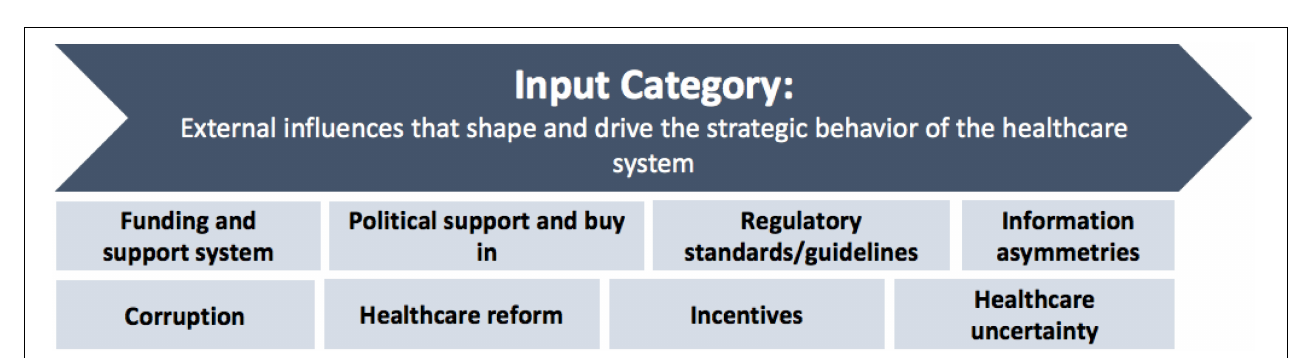
FIGURE 12 | Second part of the ecosystem canvas.